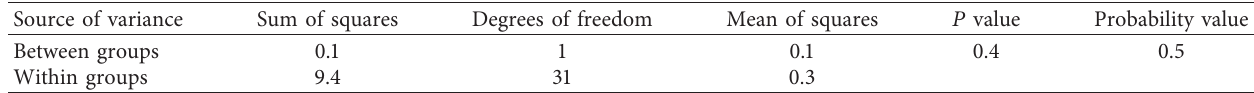
Table 9: Results of the one-way variance analysis of the quality measure of e-learning programs for faculty members for the variable of program type.